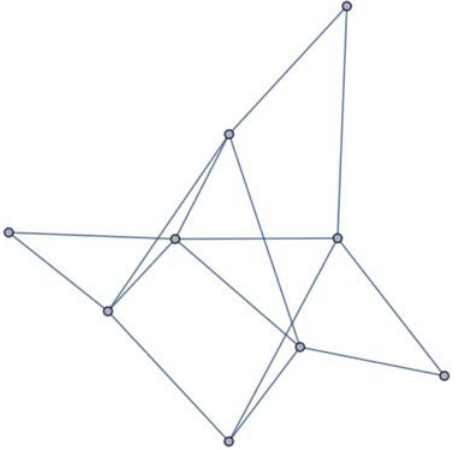
Figure A2: Graph with graph6 string HFRJIOY